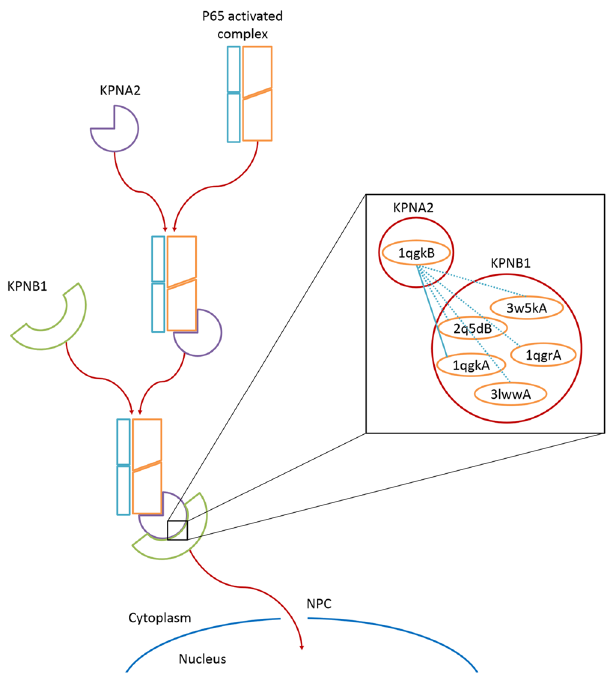
Figure 10. Pathway for p65 import based on Liang et al . 64